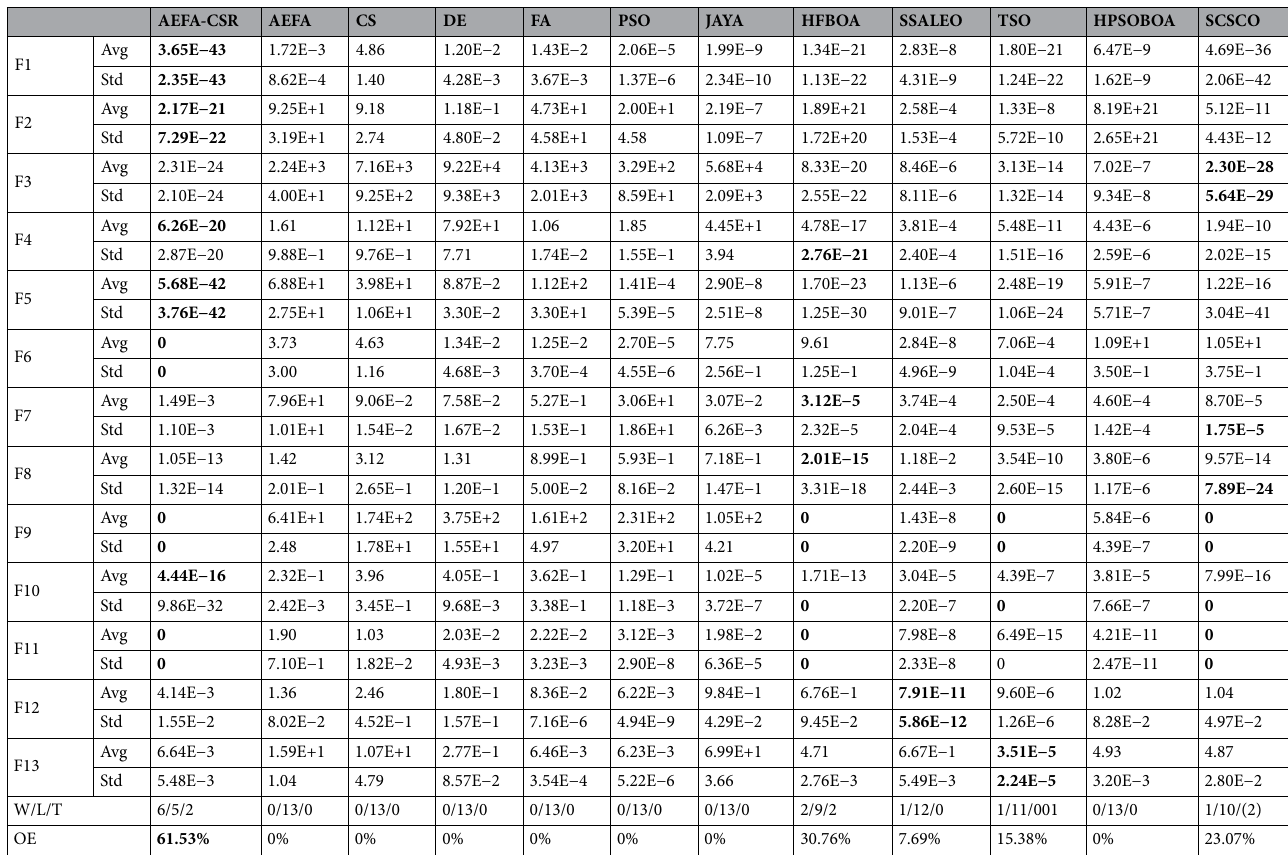
Table 5. F1–F13 comparison with dimension = 50 and population = 60. Significant values are in